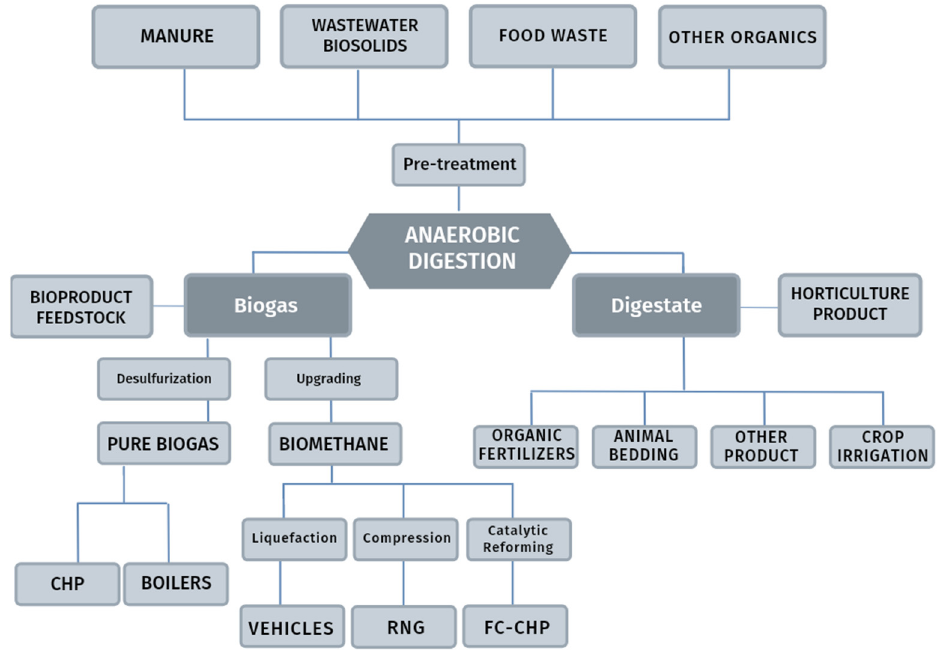
Figure 2. Possibilities of using